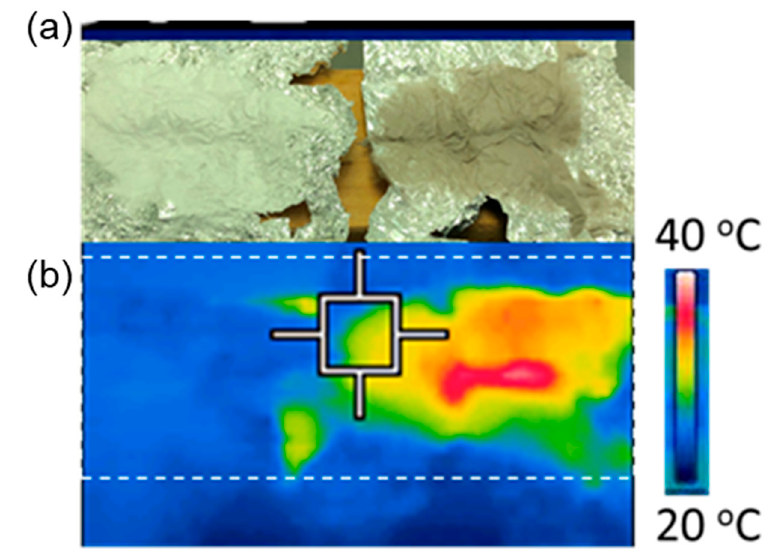
Figure 5. ( a ) Optical picture and ( b ) infrared thermal image of the CA and CA-CdSe fiber mats.